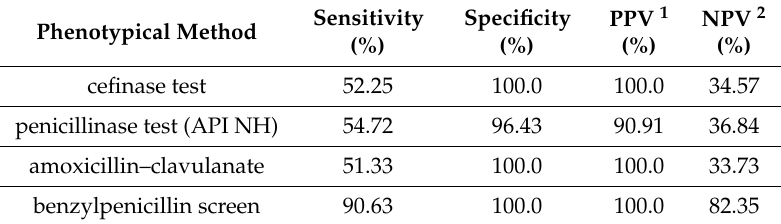
1 PPV—Positive predictive value; 2 NPV—Negative predictive